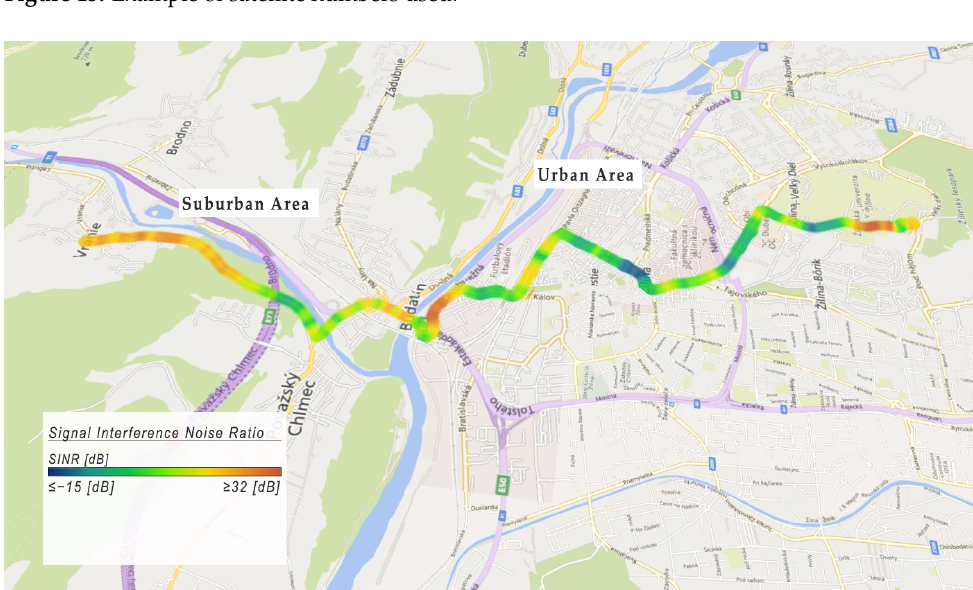
Figure 13. Example of satellite numbers used.